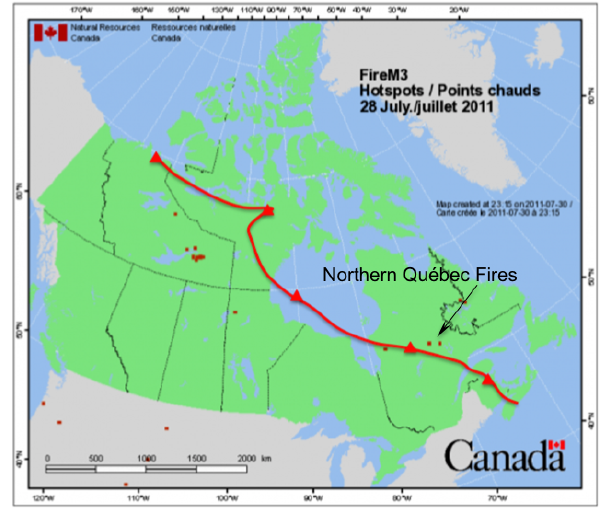
Figure 7. 5-day HYSPLIT air mass back trajectory arriving at 12:00UTC, overlaying the fire hotspot map for 28 July